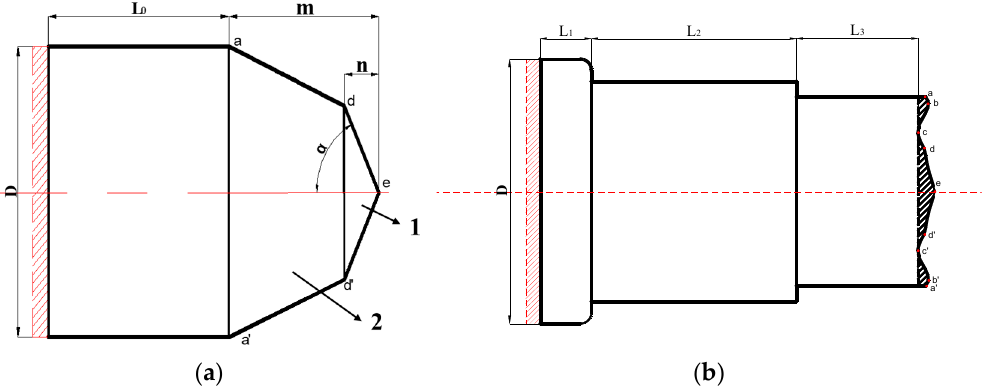
Figure 10. Shapes of billet with a variable cone angle and its product: ( a ) shape of billet with a variable cone angle; 1 is the first cone section, 2 is the second cone region; ( b ) shape of a typical rolling piece from such a billet.